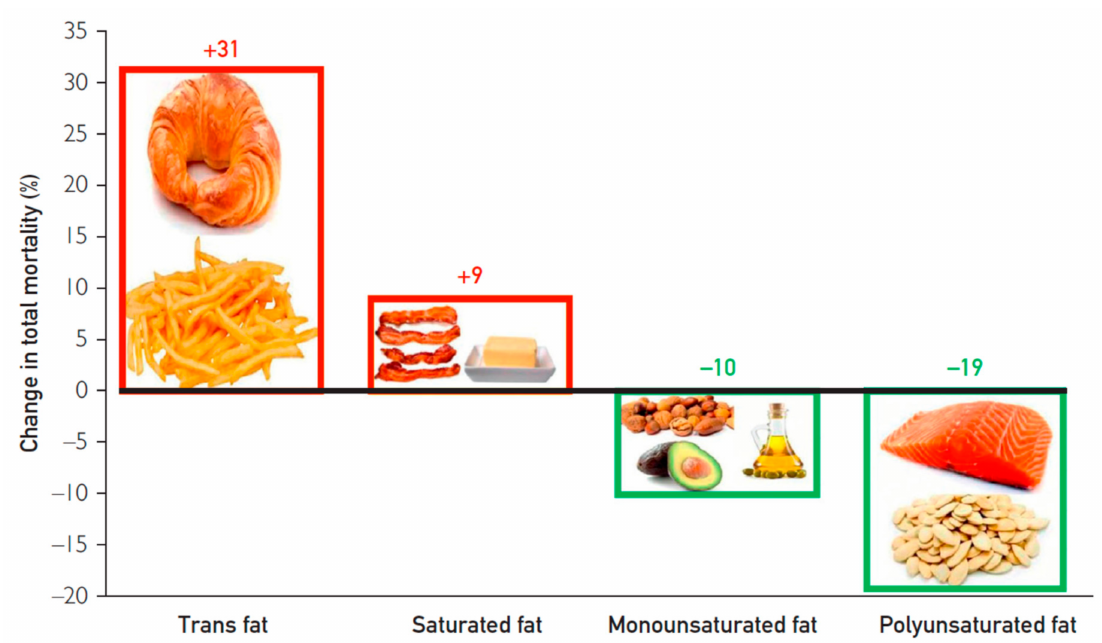
Figure 1. Substitution of different fatty acids for carbohydrate in the Nurse’s Health Study (NHS) and Health Professional’s Follow Up Study (HPFS). Hazard ratios for total mortality by replacing carbohydrates with specific dietary fats. Used with permission from O’Keefe et al.